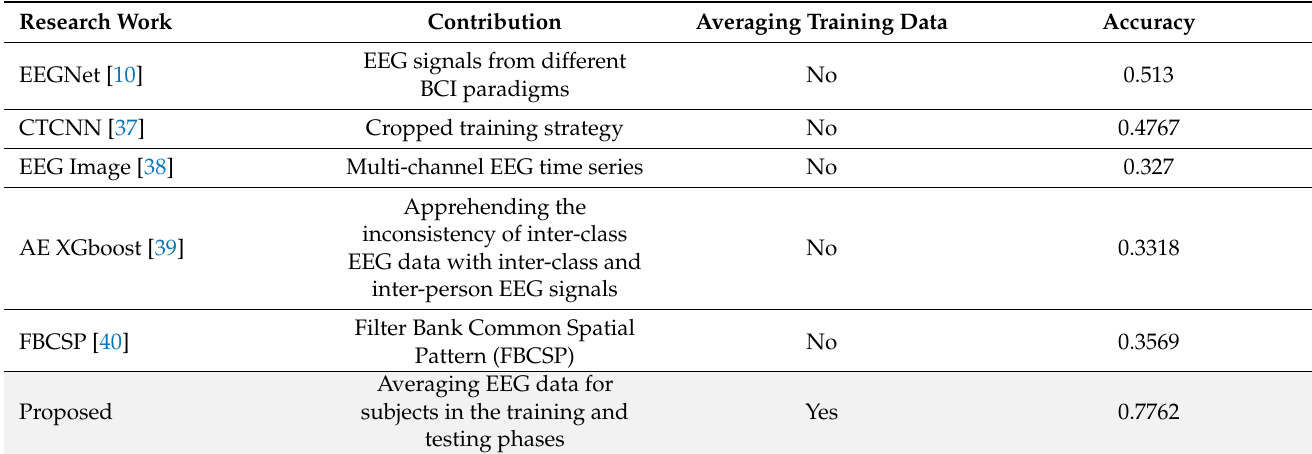
Table 8. Comparison of proposed model with recent models.